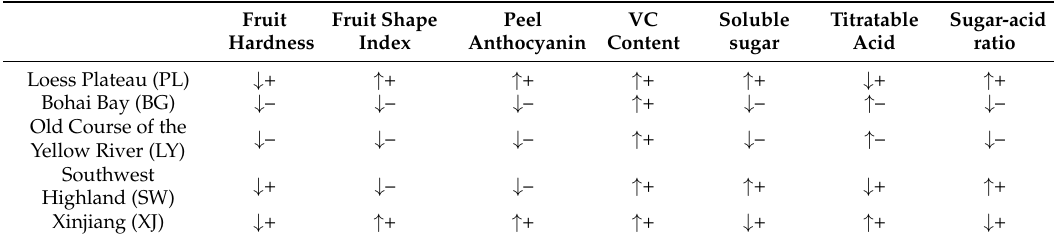
Table 4. Possible effects of climate change on apple quality in